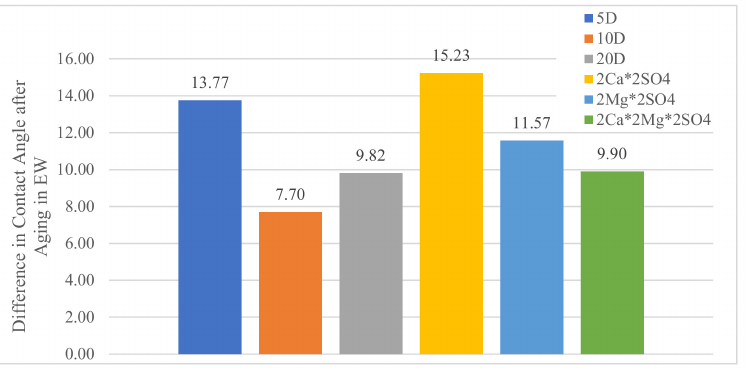
Figure 1. Contact angle difference by aging with Low Salinity Water/Engineered Water